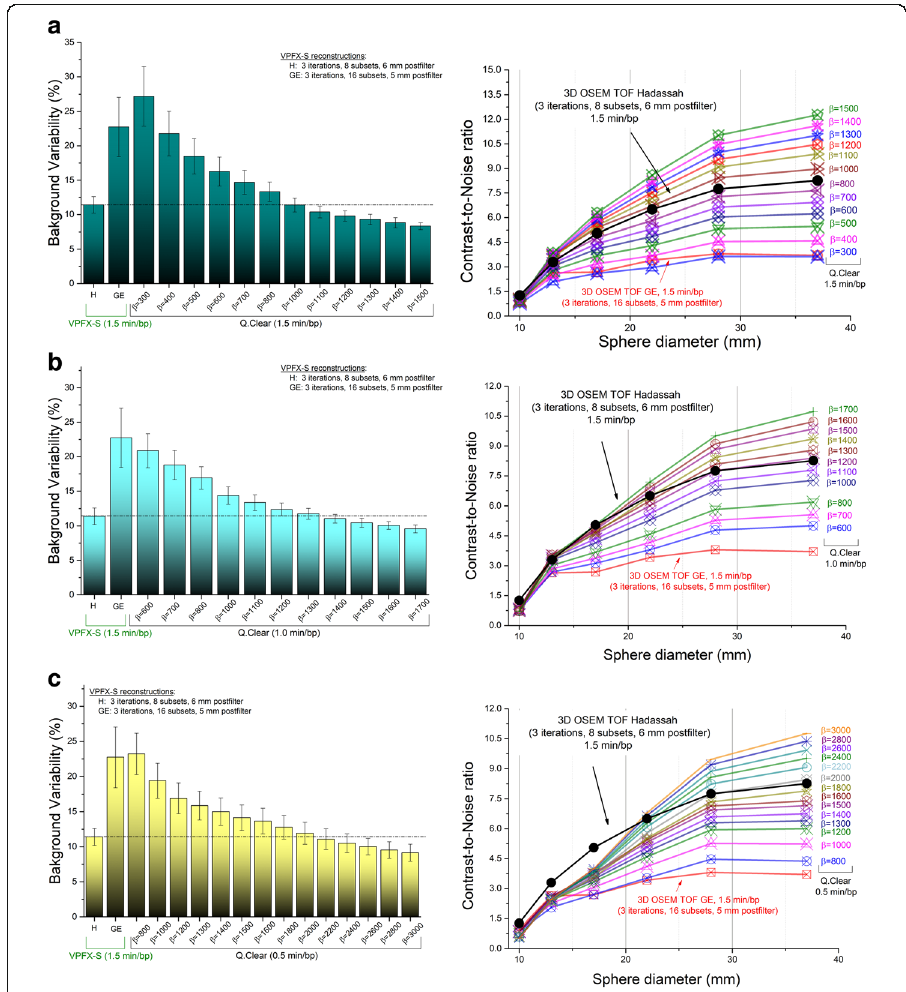
recommendation (GE) OSEM+TOF+PSF reconstruction algorithms and, Q.Clear with different values of β